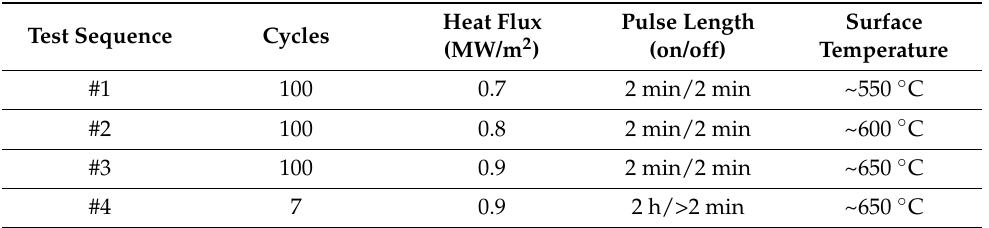
Table 6. High heat flux fatigue test sequences for the mock-up in the Helium Loop at KIT (HELOKA)